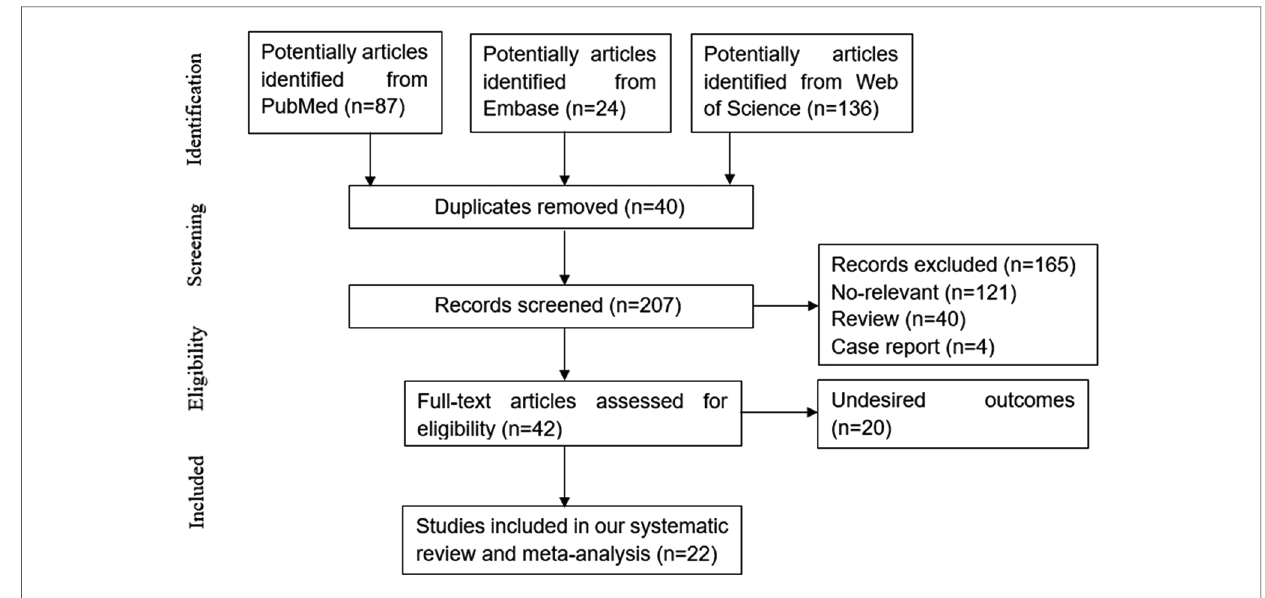
FIGURE 1 Flow chart of article